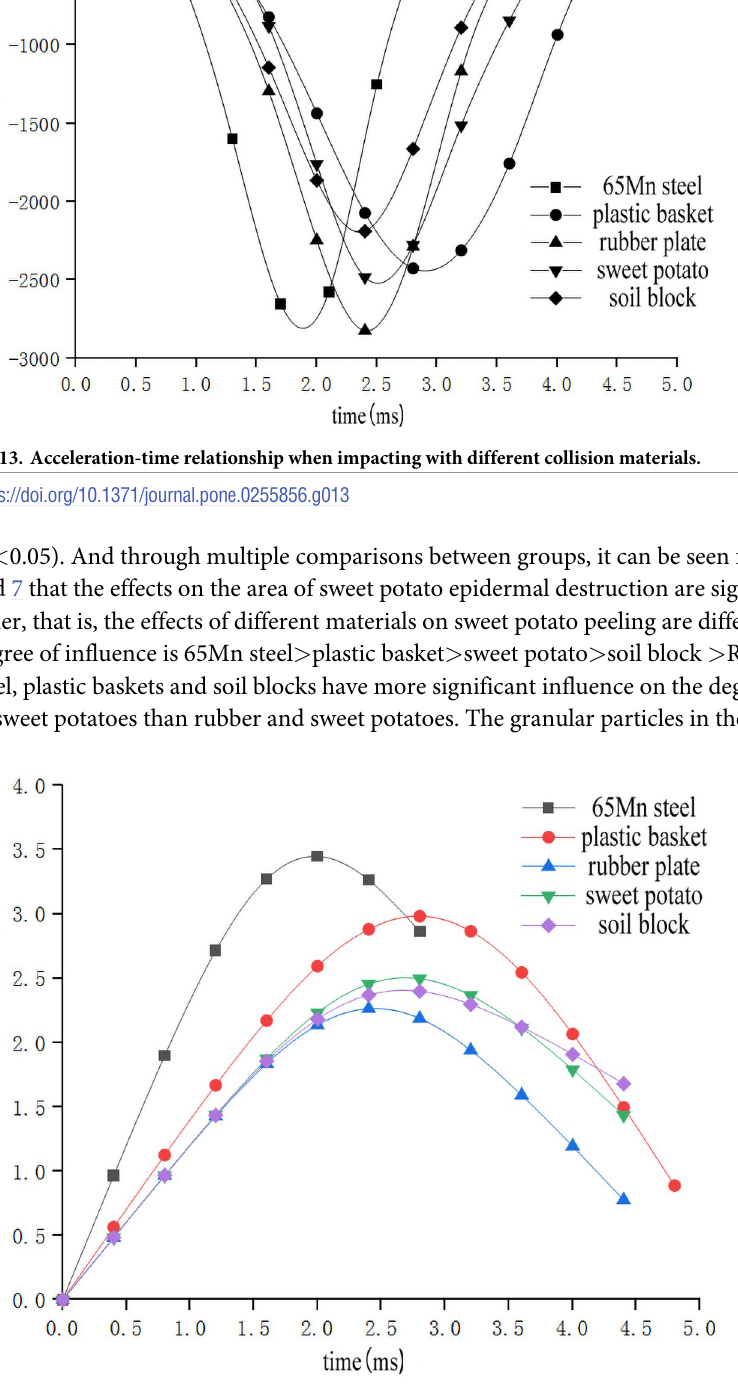
Fig 14. Impact deformation-time relationship when impacting with different collision materials.